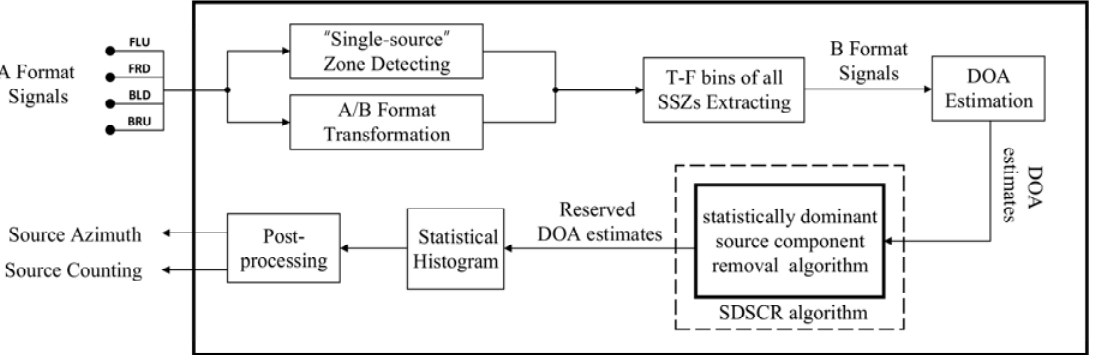
Figure 4. The block diagram for the proposed multiple sound sources localization framework.